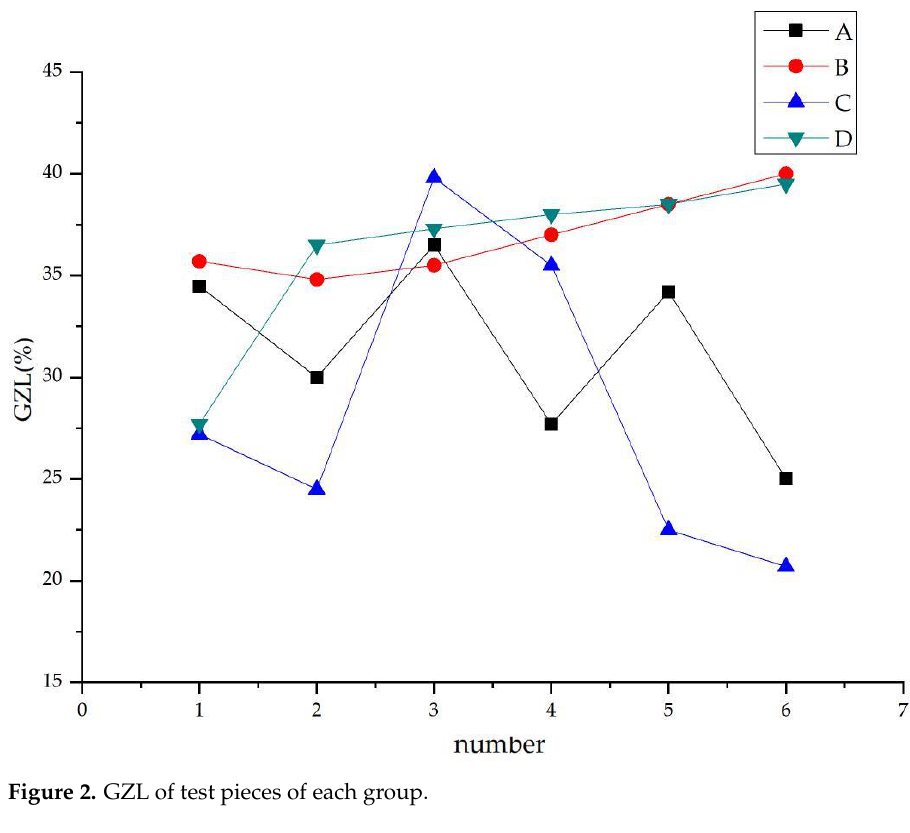
Figure 2. GZL of test pieces of each group.